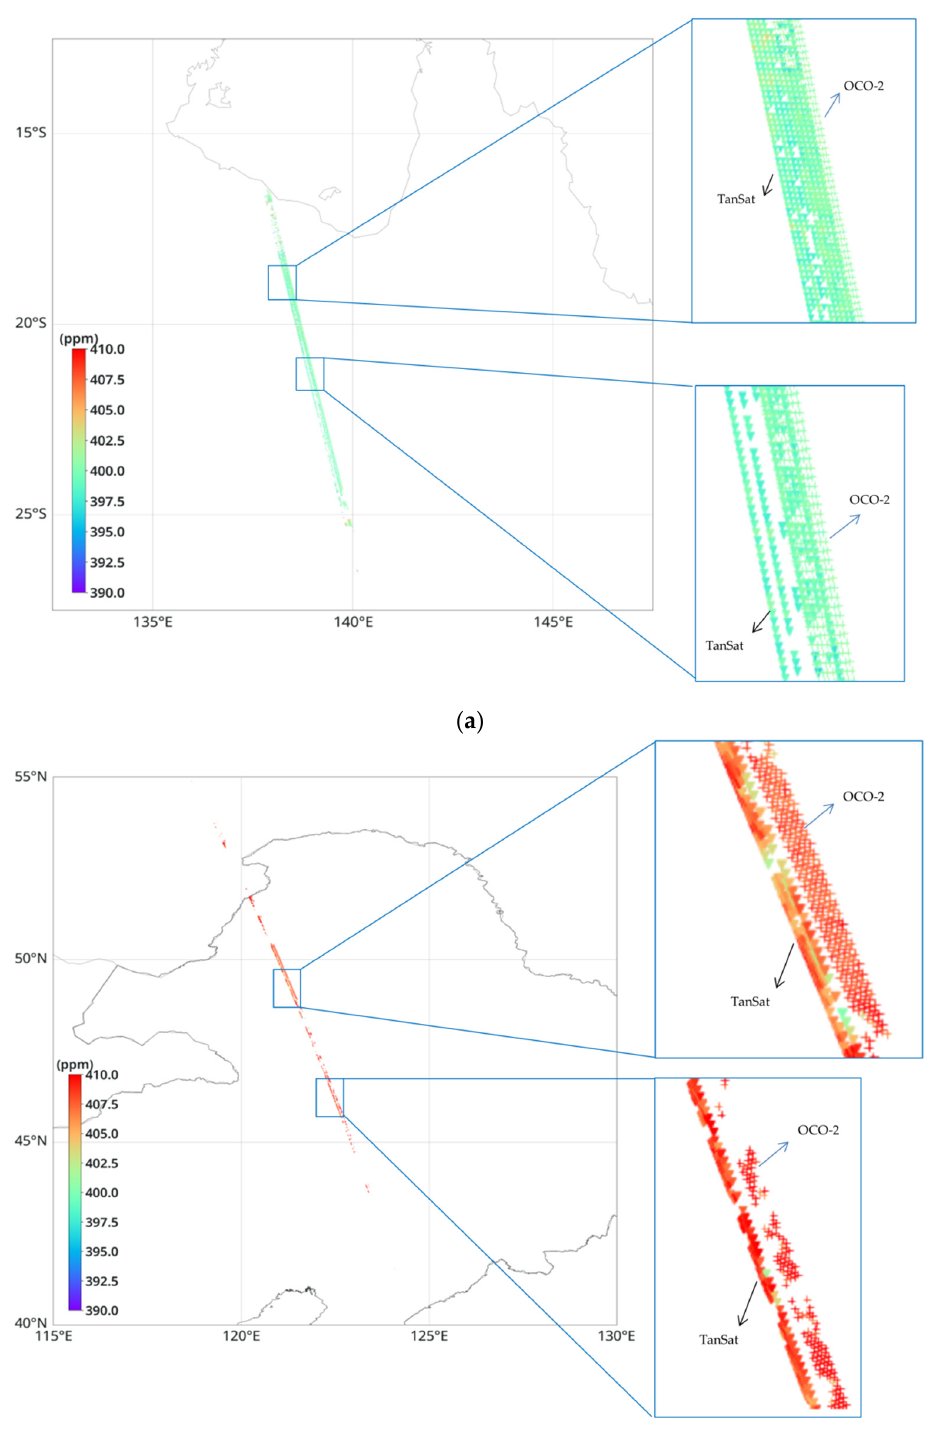
Figure 11. Comparison of the XCO 2 retrievals from TanSat and OCO-2 observations obtained using nadir mode on 20 April 2017. The XCO 2 retrievals from TanSat and OCO-2 are represented by triangle and cross respectively in ( a ) Australia and ( b ) Northeast China.